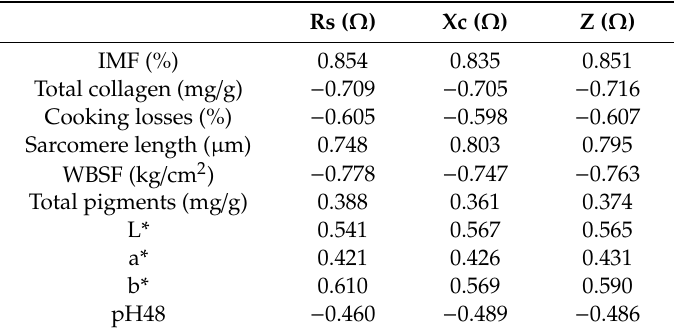
Table 3. Coe ffi cients of correlation of bioelectrical impedance (BIA) parameters with